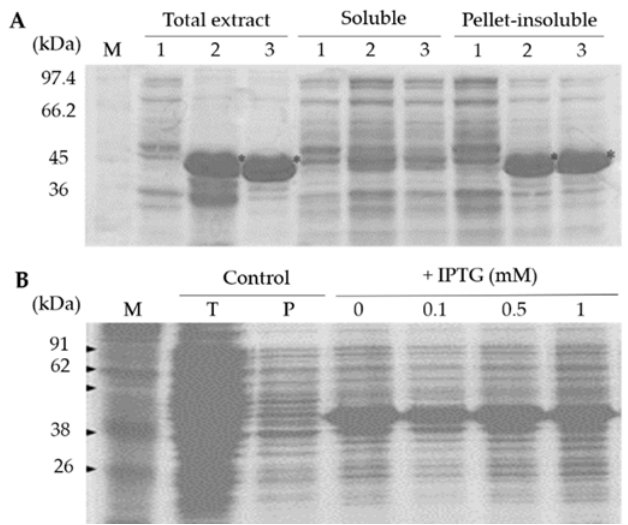
Figure 2. Electrophoresis separation of the SCMVCp recombinant protein expressed in E. coli ( A ) and the effect of IPTG concentration on SCMVCp levels ( B ); The E. coli strain BL 21 harboring a pET28a- SCMVCp construct was grown in LB liquid media at 37 °C on a 150 rpm shaker and induced with 0.5 mM of IPTG. The proteins were extracted by sonication, separated with SDS-PAGE (10% acrylamide), and stained with Commassie brilliant blue; (A) lane 1: protein extracted from the E. coli control plasmid only and lane 2–3: protein extracted from the E. coli pET28a plasmid inserted with SCMVCp - cDNA; ( B ) Control; total (T) and insoluble proteins (P) from the E. coli control without the insert, and + the IPTG representing effect of IPTG addition at the indicated concentration. Lane M is the protein marker protein.